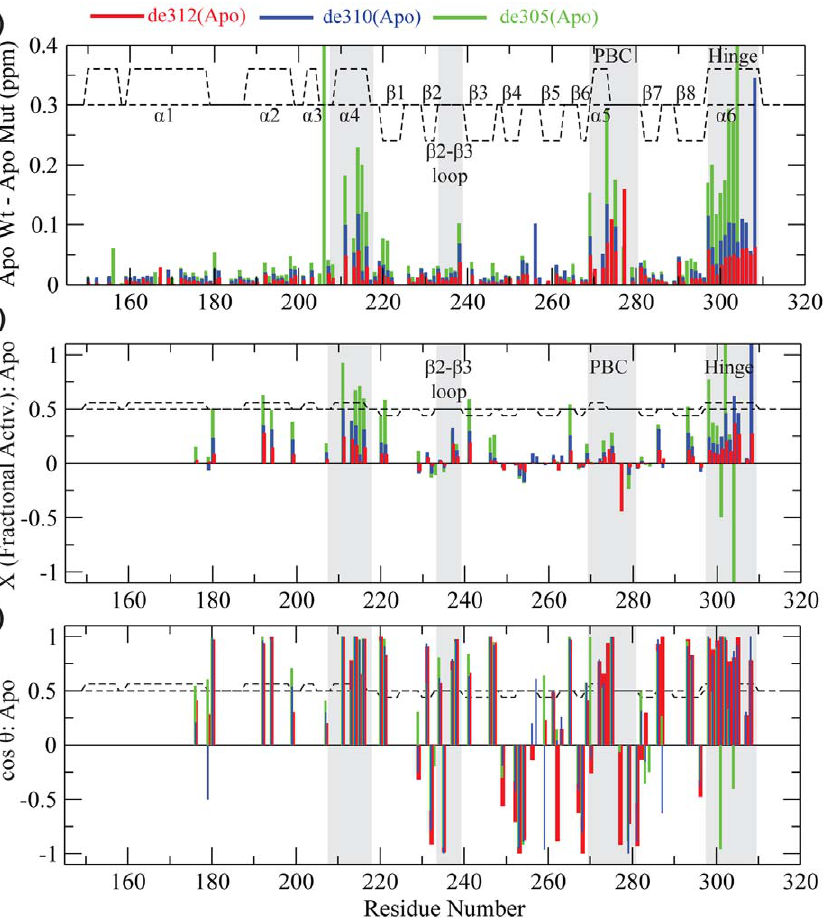
Figure 3. Chemical shift projection analysis to map the effects of the apo truncation mutants de312 (red), de310 (blue) and de305 (green) relative to Wt(apo). The dashed lines represent the secondary structure of the apo-EPAC (PDB ID: 2BYV). The grey highlights are regions subject to some of the most significant cAMP-dependent changes on the Wt(apo). ( a ) The compounded chemical shift profile of the apo-mutants relative to apo-Wt, that is the magnitude of vector A in Figure 2A. ( b ) Fractional shift toward activation achieved by the mutations in the absence of cAMP and with compounded chemical shifts greater than 0.05 ppm between the Wt(apo) and Wt(holo) state. ( c ) Cosine values for the projection angle, as in Figure 2A, which is also an indicator of the direction of chemical shift movement along the activation path (vector B in Fig.